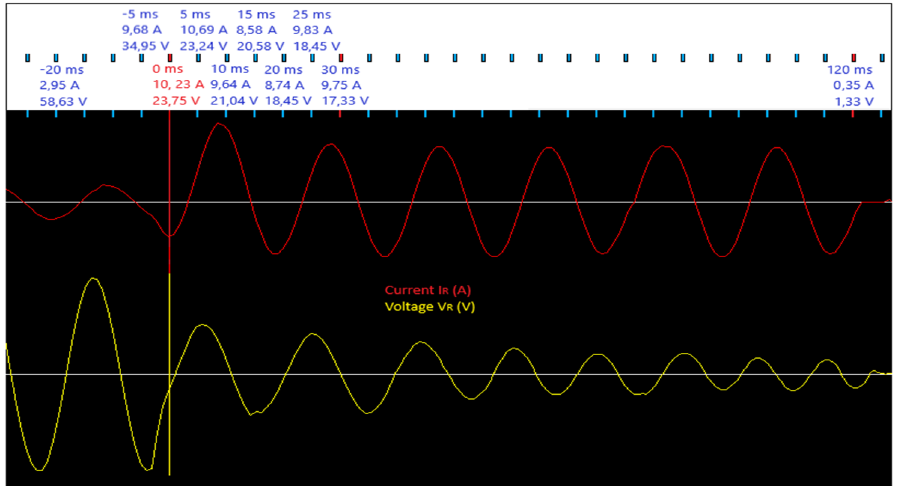
Figure 1. Fault oscillogram on R phase of the 110 kV power line.